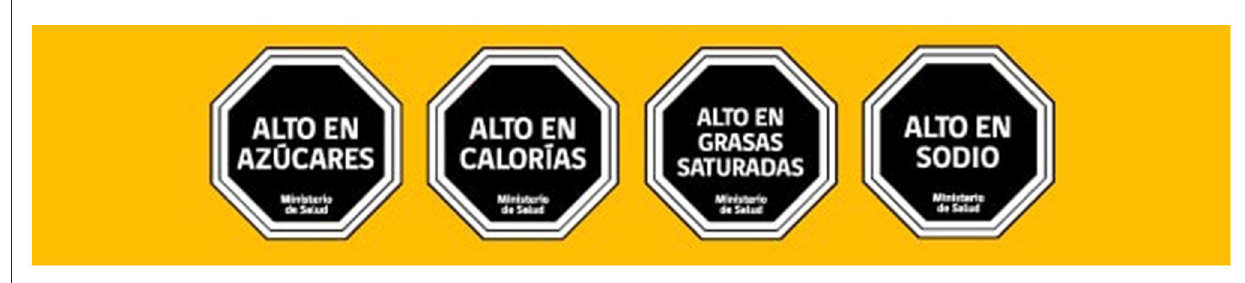
FIGURE1 Warning labels from Chile. Image taken from Grummon (2019) under creative commons attribution 4.0 international license.